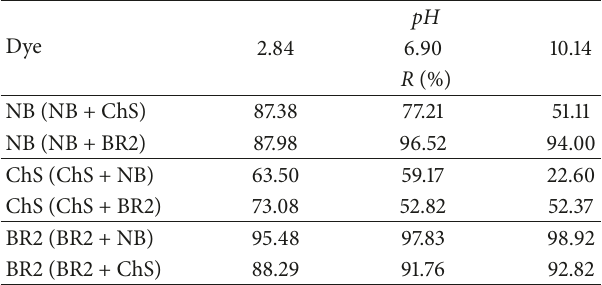
Table 8: Effect of solution pH on dyes removal efficiency in the case of binary